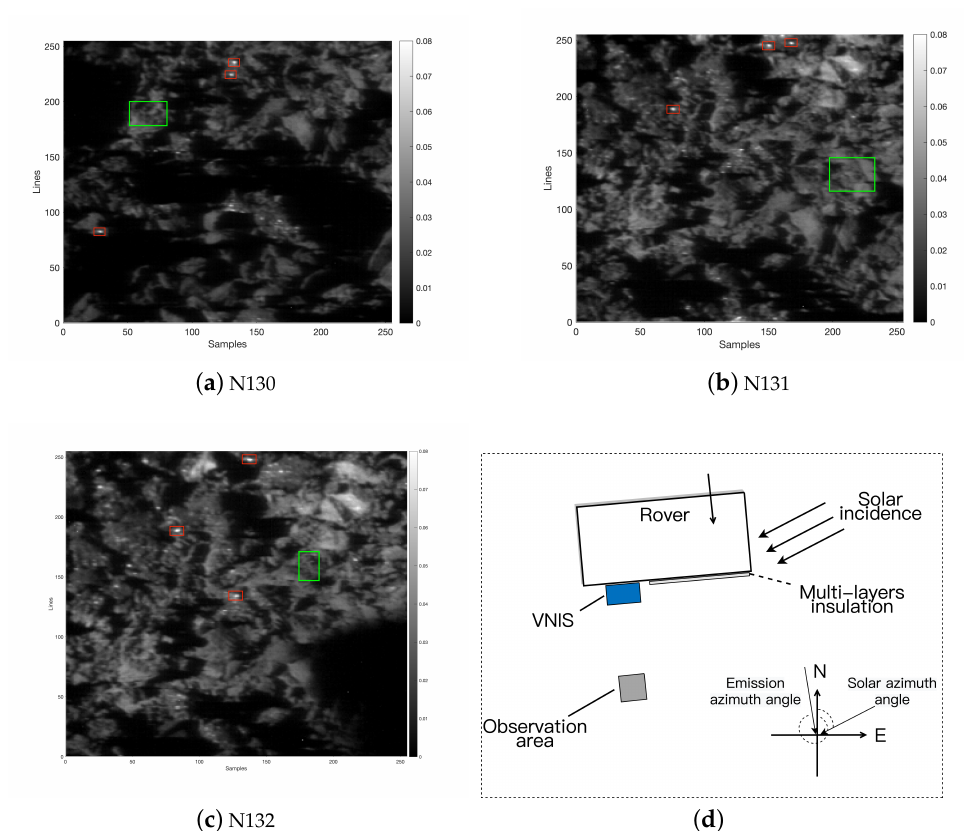
Figure 9. ( a – c ) Radiance images of lunar surface observed by the Yutu-2 rover. The images are stretched from 0 to 0.08 to illustrate the albedo variation. The red rectangles indicate the obvious bright spot areas. The normal areas were marked by the green rectangle. The image IDs are N130, N131, and N132. ( d ) Schematic of the angle relationships between the illumination angle and vehicle body